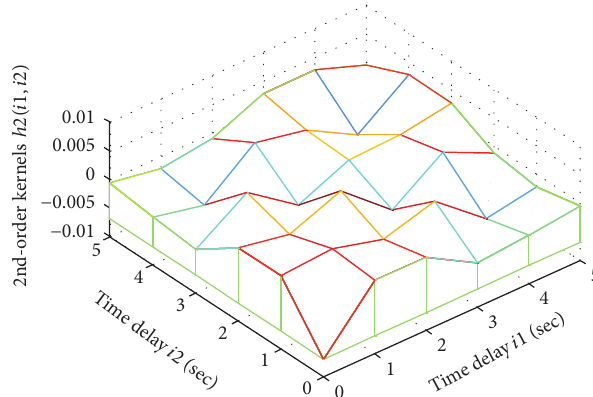
Figure 4: The second-order time domain kernels of the shaft system in overspeed